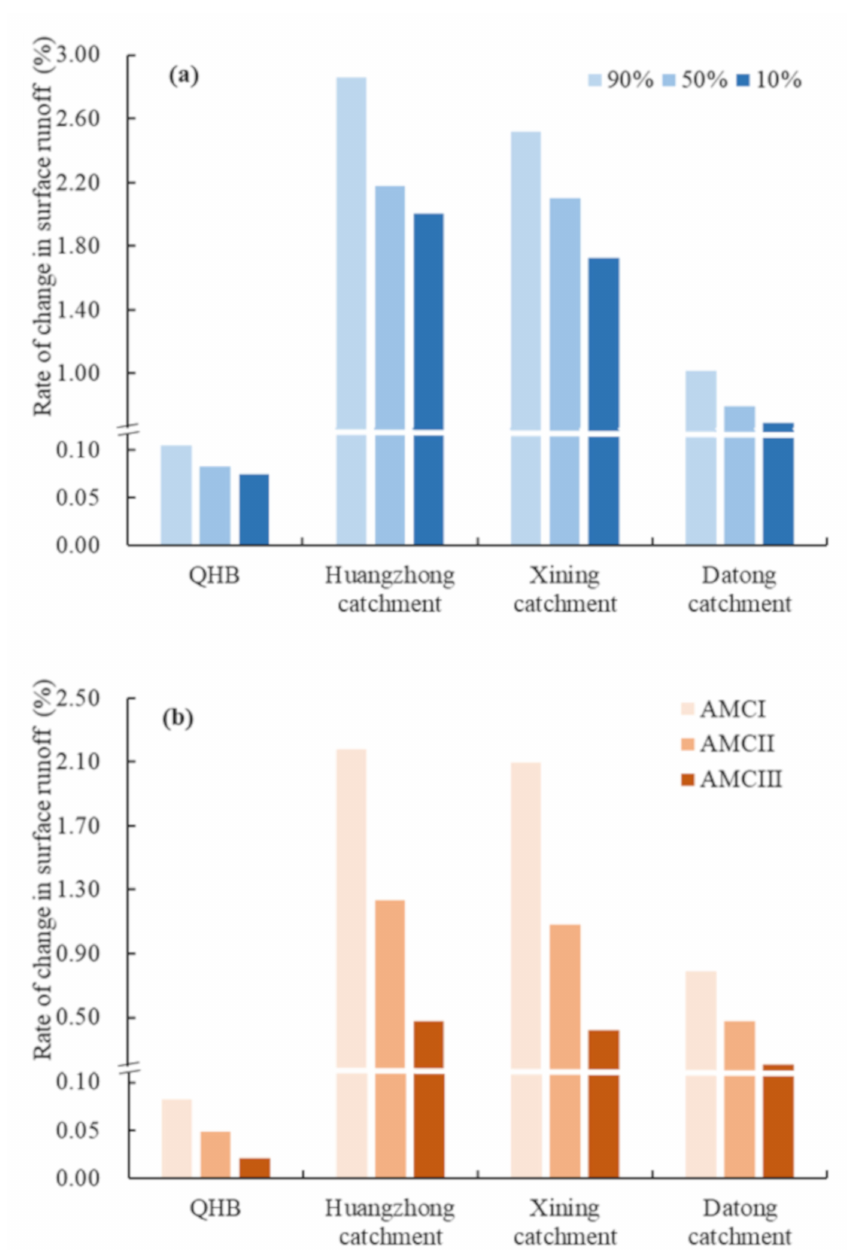
Figure 11. The UEI on surface runo ff under di ff erent scenarios. ( a ) Under di ff erent rainfall frequencies; ( b ) under di ff erent antecedent moisture